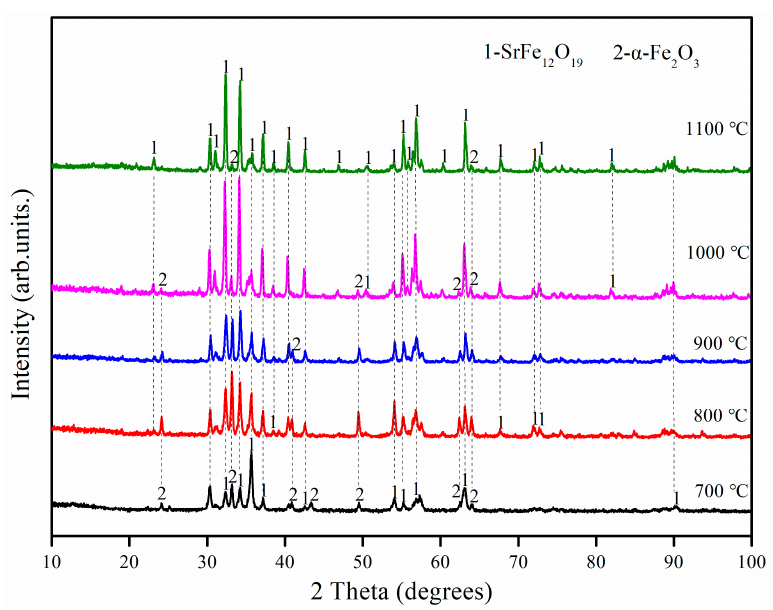
Figure 6. XRD patterns of SrFe 12 O 19 with an Fe/Sr molar ratio of 11.8 and annealed at different temperatures. Table 2. E ff ect of annealing temperature on the phase content, crystalline size, and magnetic properties of the obtained SrFe 12 O 19 samples with an Fe / Sr molar ratio of